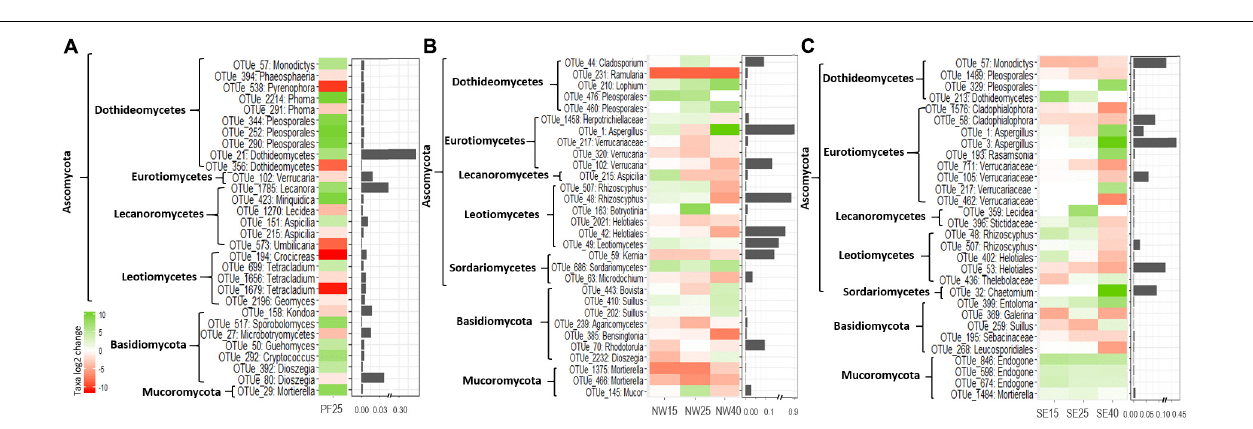
FIGURE 6 | The most pronounced changes in the relative abundance (log2-fold change) of fungal OTUs during the incubation for (A) PF soil: 4 ◦ C compared with 25 ◦ C; (B) NW soil: 4 ◦ C compared with 15, 25, and 40 ◦ C; and (C) SE soil: 4 ◦ C compared with 15, 25, and 40 ◦ C. OTU names are given at the deepest successful classification and then grouped according to phylum. Ascomycota are defined to the class level. Changes are displayed by a red (negative) to green (positive) color range and bar plots show relative abundance (%) during